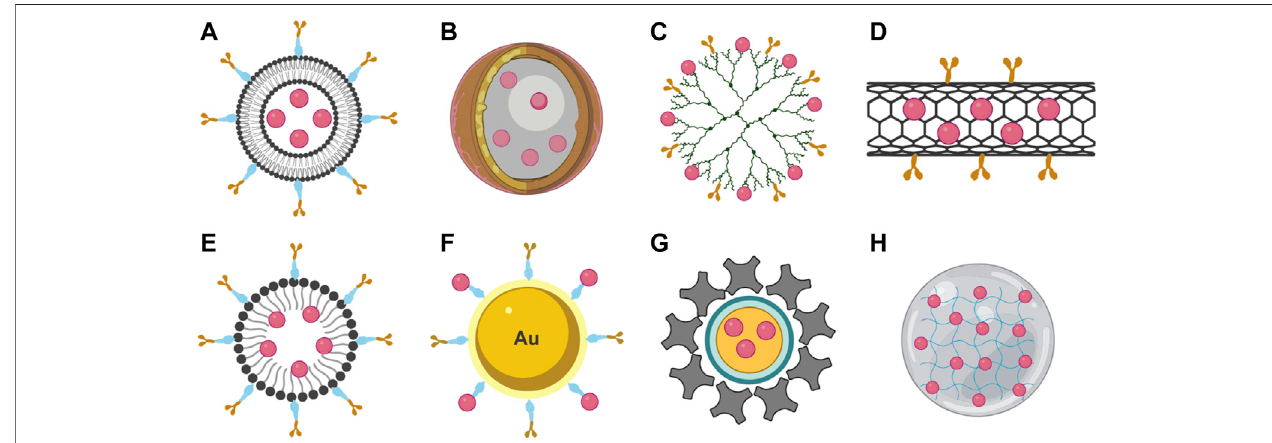
FIGURE2| Typesofnanostructures usedasDDS. (A) Liposome, (B) nanocapsule, (C) dendrimer, (D) nanotube, (E) polymericmicelle, (F) metallic nanostructure, (G) quantum dots, and (H)